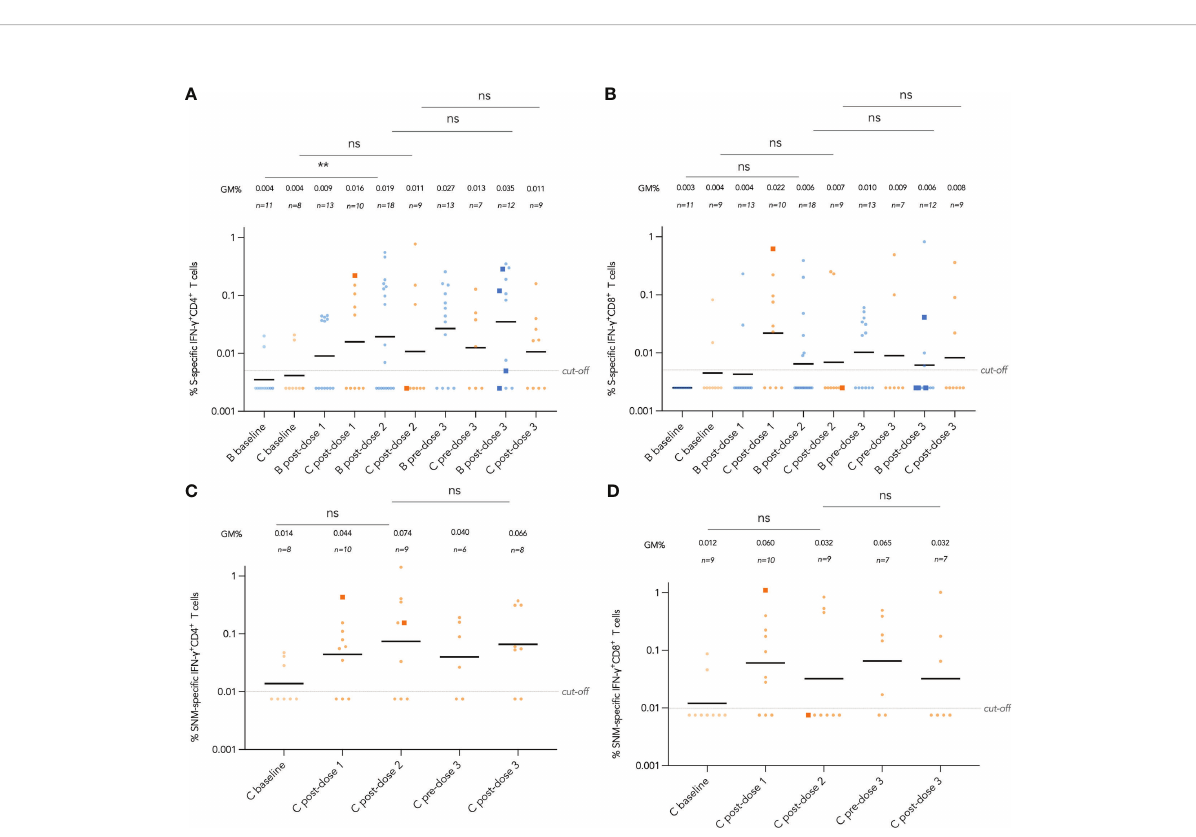
FIGURE 5 Longitudinal analysis of wild-type (WT) S and S, N and M protein peptide pool-speci fi c interferon- g (IFN- g ) + CD4 + and CD8 + T cells by vaccine brand and route. S-speci fi c IFN- g + CD4 + and CD8 + T cell responses are shown in (A, B) respectively for both BNT162b2 and CoronaVac recipients, while added SNM-speci fi c IFN- g + CD4 + and CD8 + T cell responses are shown in (C, D) for CoronaVac recipients. Samples from the same patient were paired between baseline and post-dose 2 timepoints as well as post-dose 2 and post-dose 3 timepoints, and compared with paired t test after natural logarithmic transformation with p-values denoted (**, P<0.01; ns, not signi fi